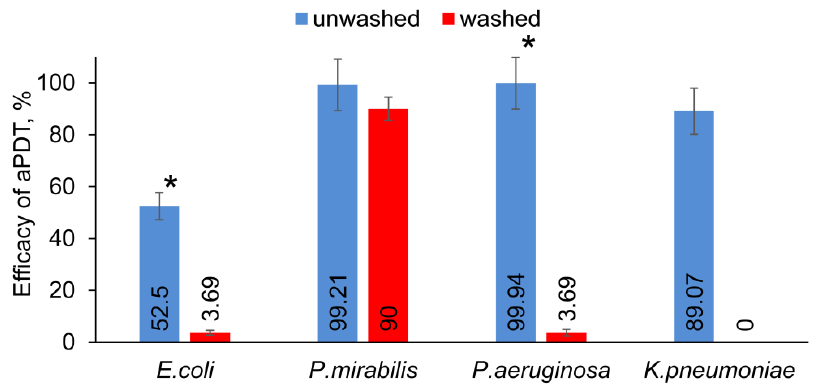
Figure 2. The influence of the extracellular photosensitizer on the efficacy of aPDT of Gram-negative bacteria. Bacteria were incubated with Fotoditazin and Triton X-100 for 15 min at room temperature in the dark. Before irradiation by continuous wave laser at 150 mW, part of each sample was washed from unbound chemicals. Statistically significant differences compared to the washed samples (*) are marked.